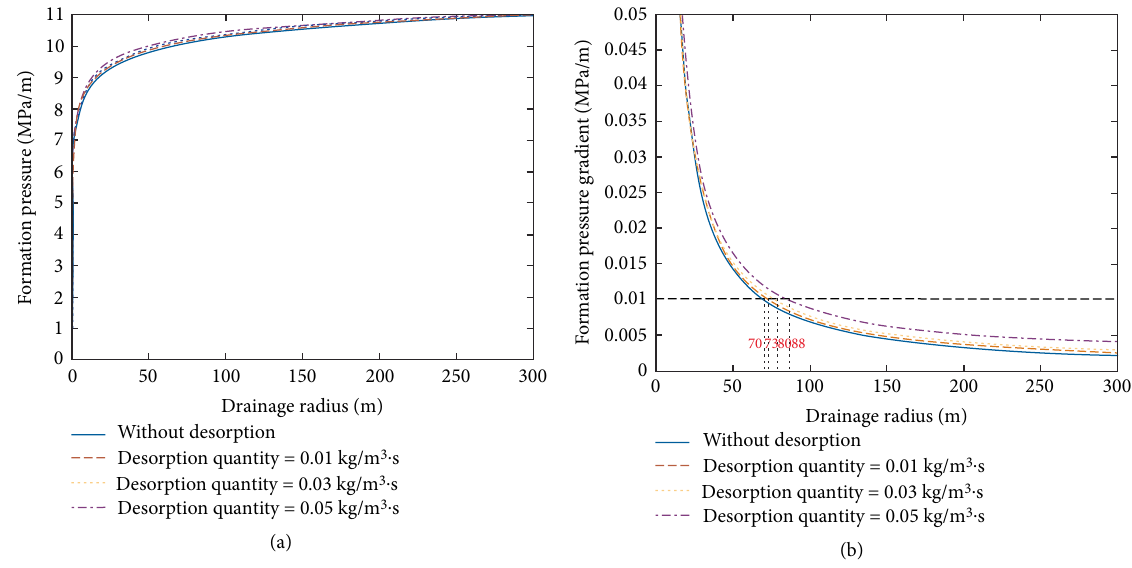
Figure 7: Effect of desorption on formation pressure and formation pressure gradient. (a) Relationship between formation pressure and drainage radius under different desorption quantity. (b) Relationship between formation pressure gradient and drainage radius under different desorption quantity.